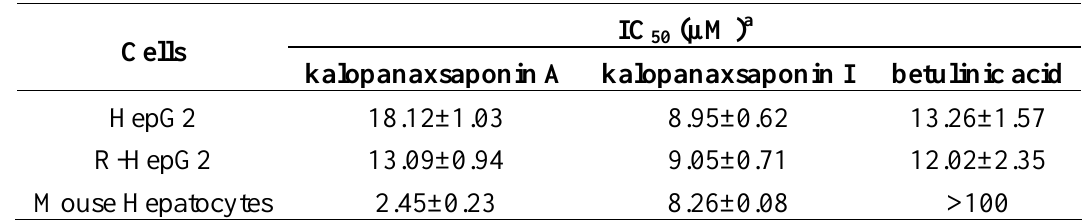
Table 1. IC values of kalopanaxsaponins A and I on different cell lines and normal 50